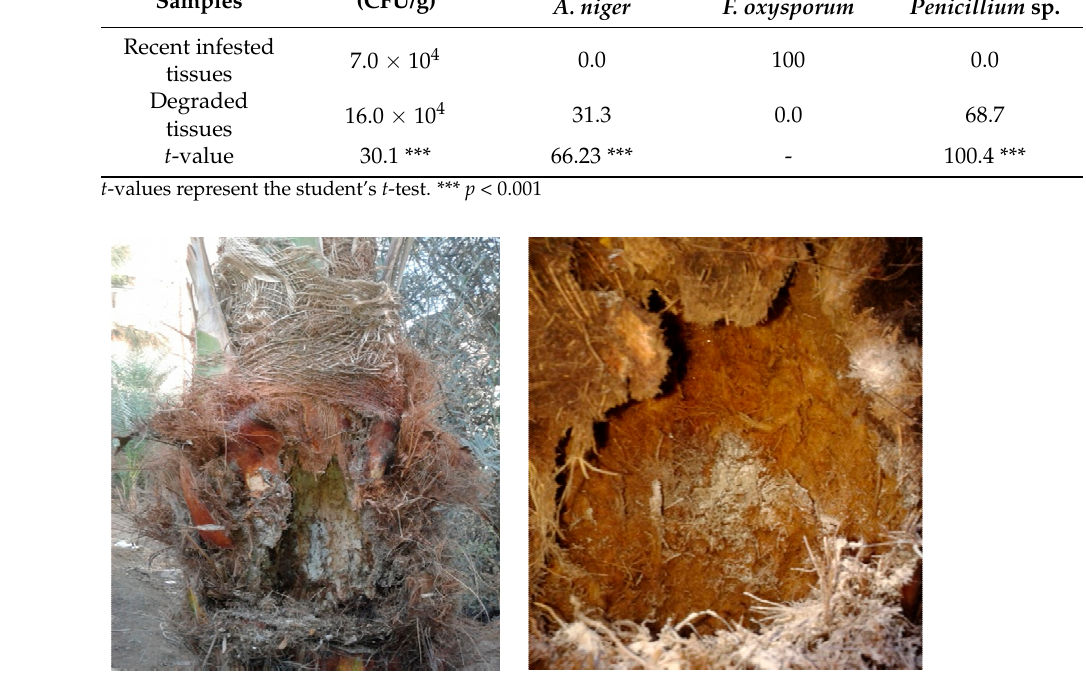
Figure 2. The appearance of fungal mycelia in the date palm trunk infested with RPW. Recently infested trunk ( left ), degraded tissue ( right ).